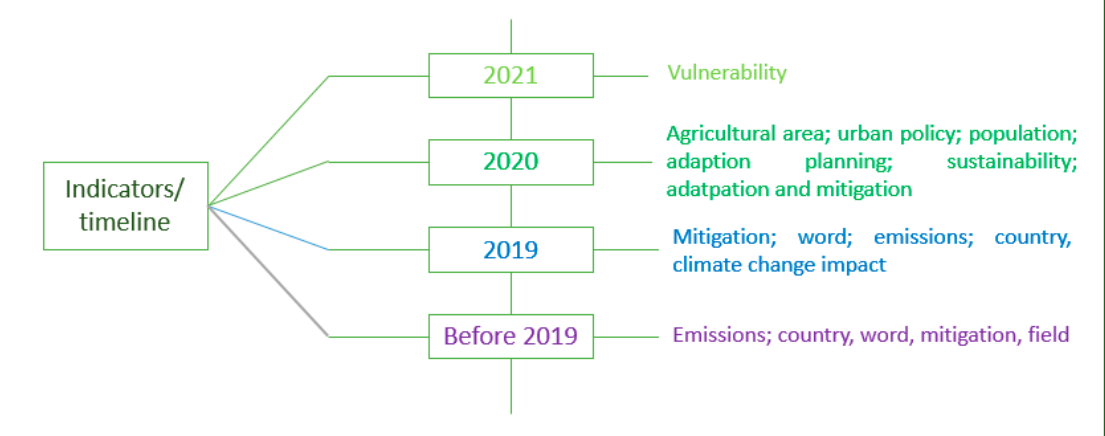
Figure 5. Online indicators between 2019 and 2021. Notes: Elaborated by the authors based on the literature via VOSviewer Software (2022). literature via VOSviewer Software